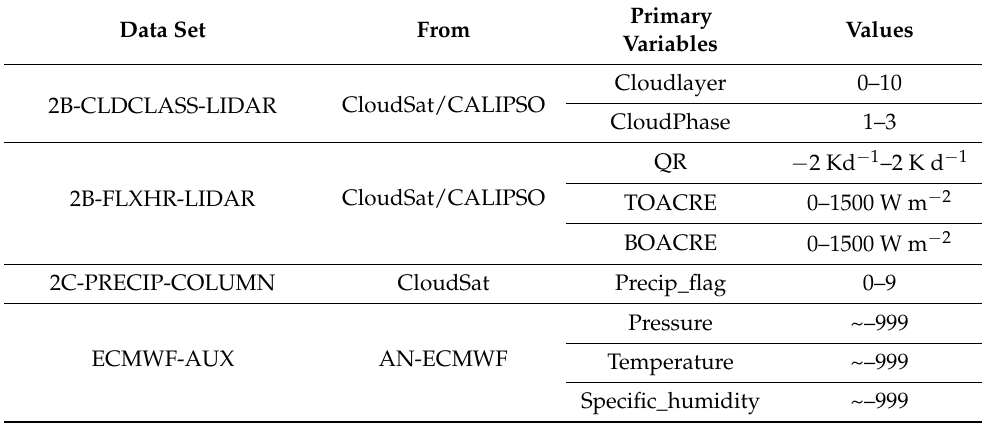
Table 2. Satellite